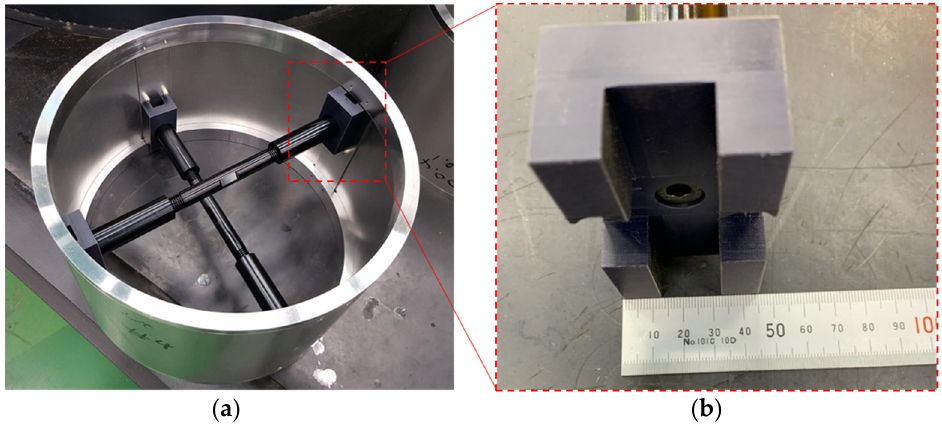
Figure 9. Picture of jig to give forced displacement: ( a ) full picture; ( b ) contact part of the jig. Figure 10 demonstrates the location for the deformation measurement in the